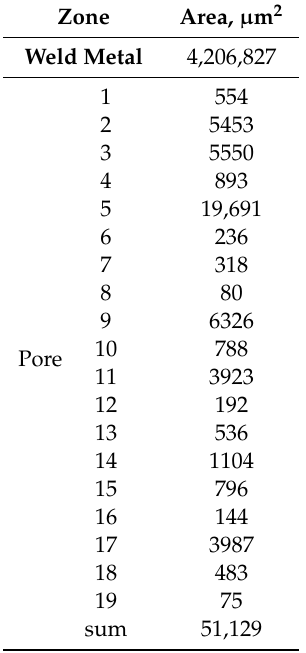
Table 2. The results of the weld and pores surface area